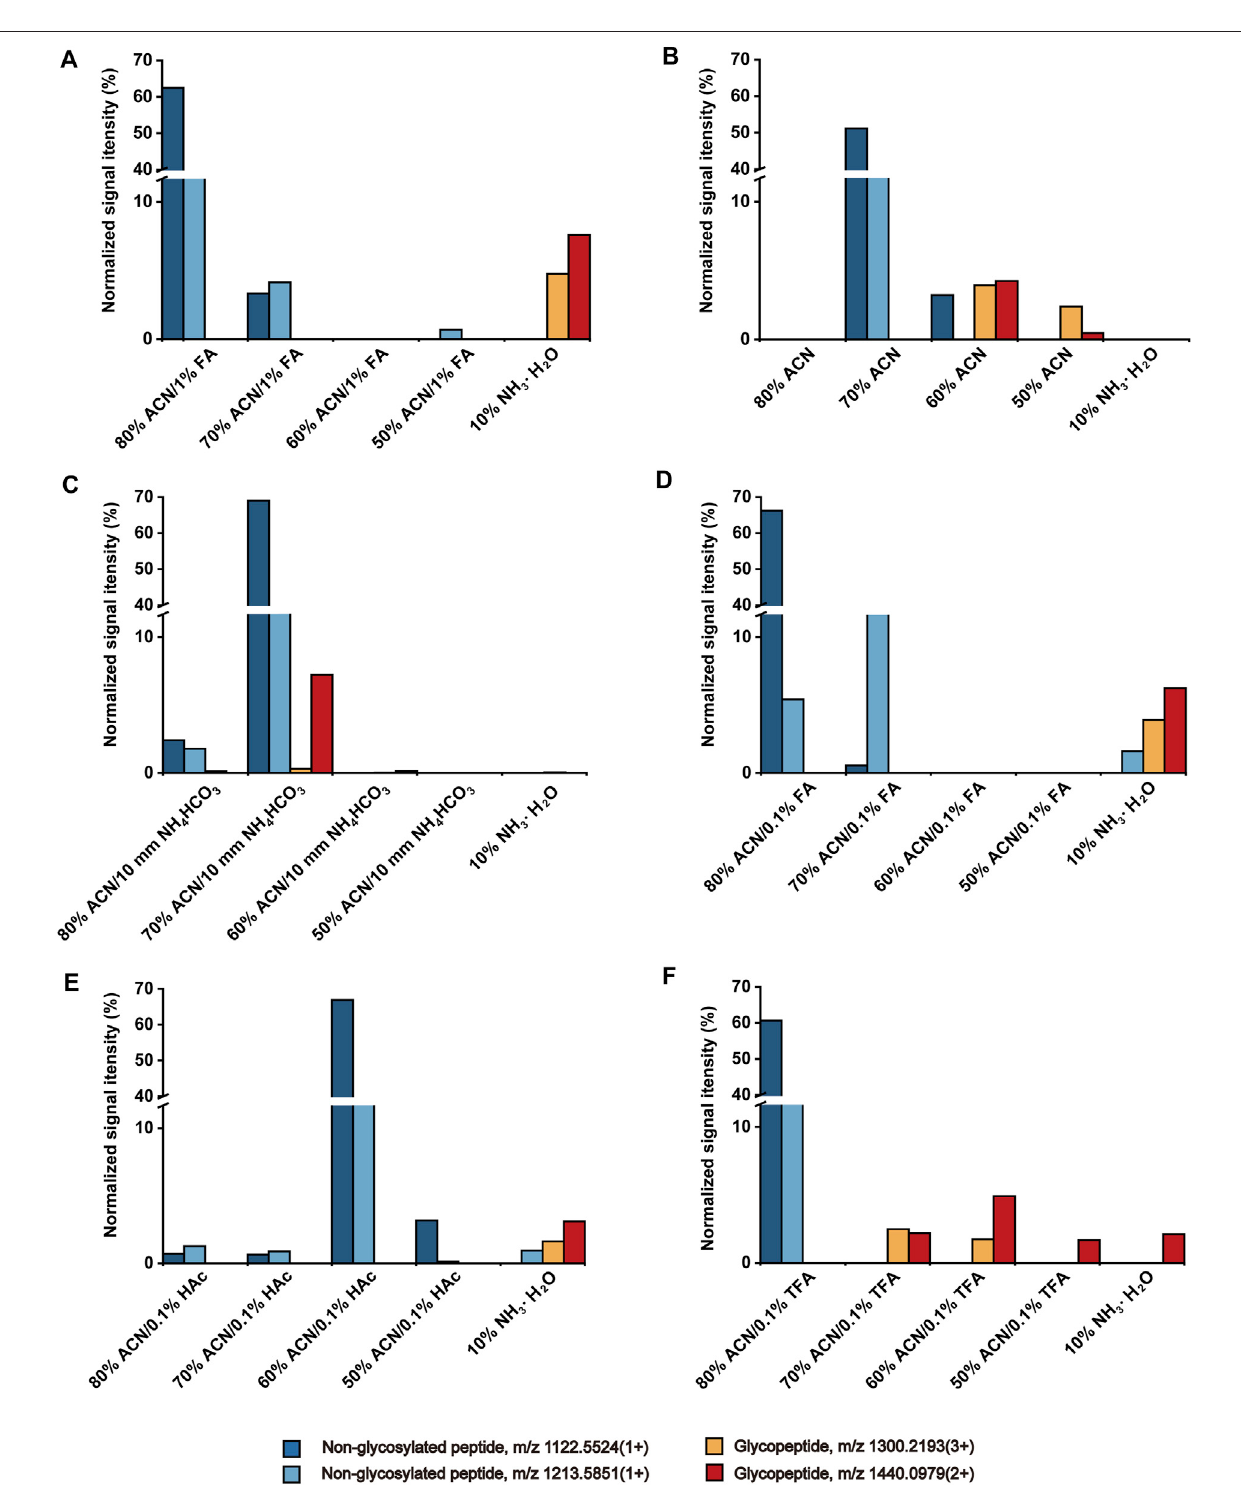
FIGURE 1 | Effect of ACN content (A) , solution pH (B, C) , and types of acid additive (D – F) to the retention of peptides on HBS materials.